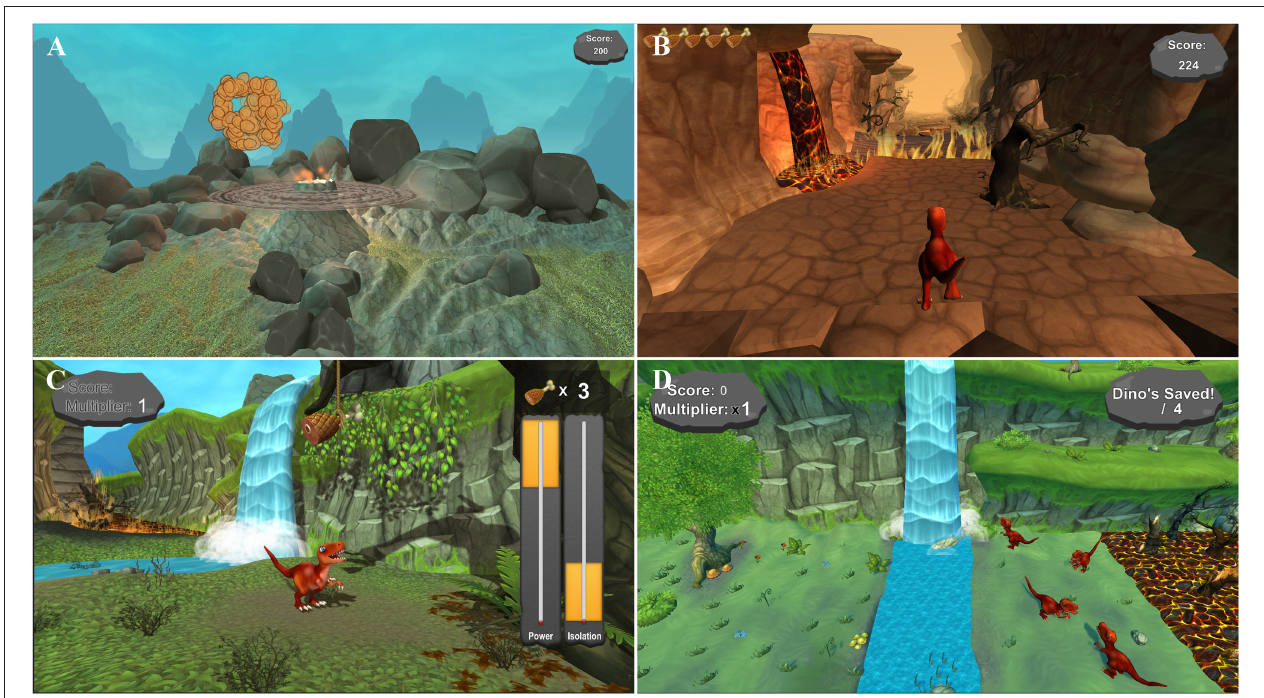
FIGURE 1 | ADAPT-MP mobile games. (A) Volcanic Crush teaches basic control, including flexion, extension, and co-contraction. (B) Dino Sprint teaches sequences of contractions (flexion, extension, co-contraction). (C) Dino Feast teaches muscle isolation (flexor vs. Extensor) and proportionality. (D) Dino Claw reinforces isolation and proportionality and allow for practice of activities of daily living via 3-D arm